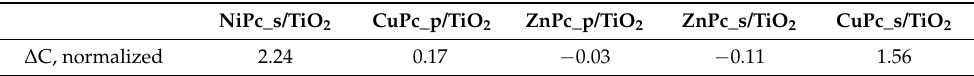
Table 7. ∆ C normalized values, calculated from relative SMX concentrations during the degradation experiment in